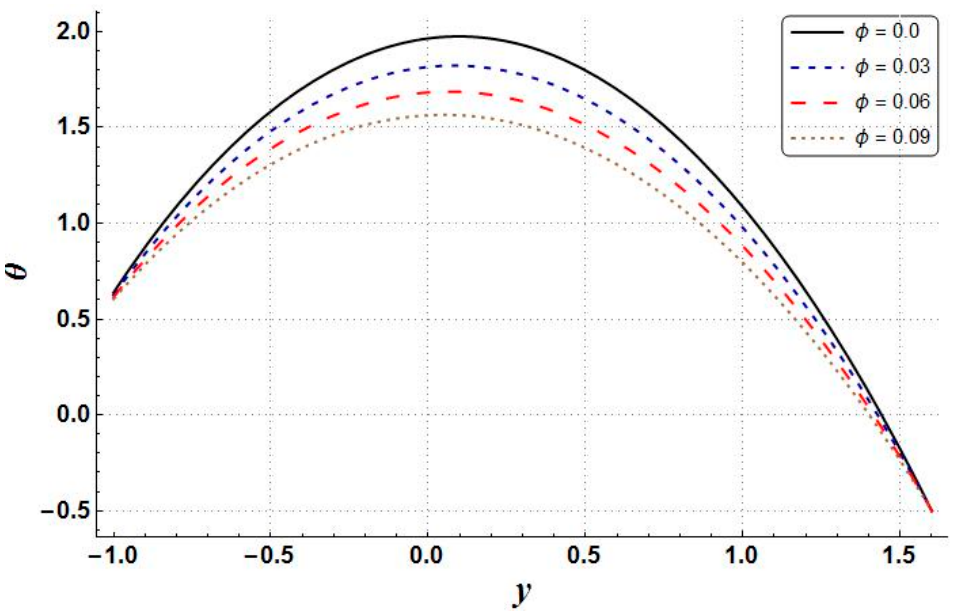
Figure 2. Influence on θ through changing values of φ , where γ = π M = 1, k = 2, a = 0.6, m = 1, d = 0.7, Br = 0.2, b = 0.5, ∈ = 2, η = 0.8.